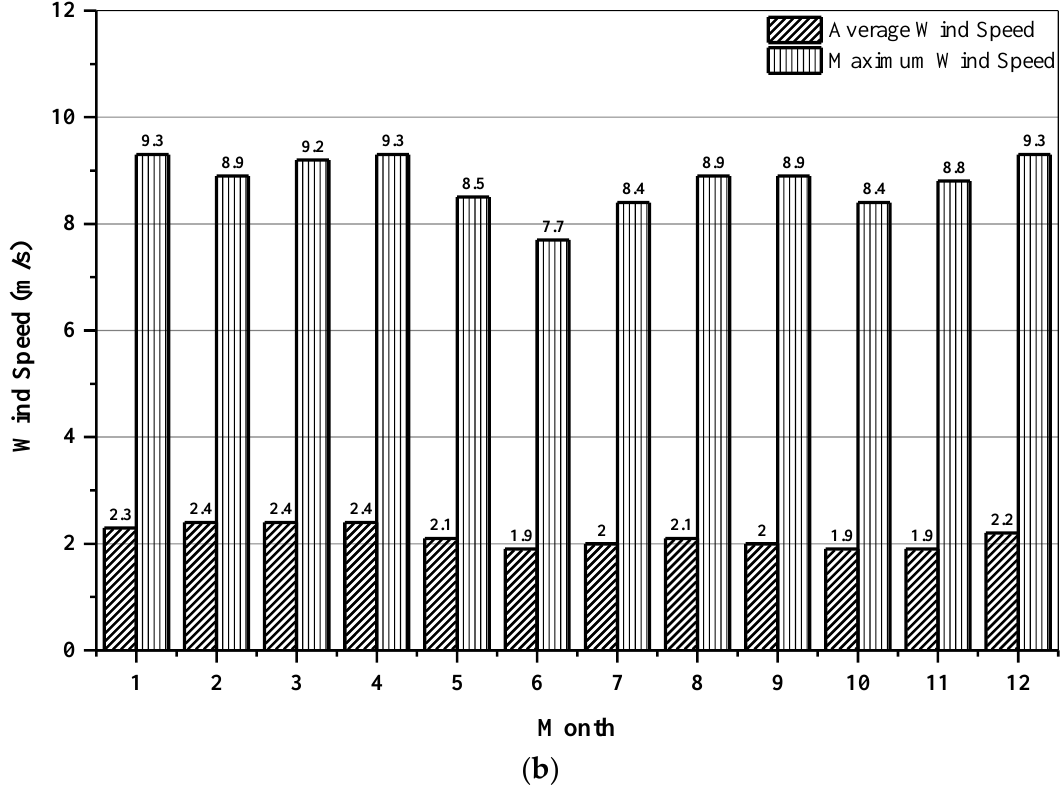
Figure 5. ( a ) Wind rose chart and ( b ) wind speed plots at Ulsan port.